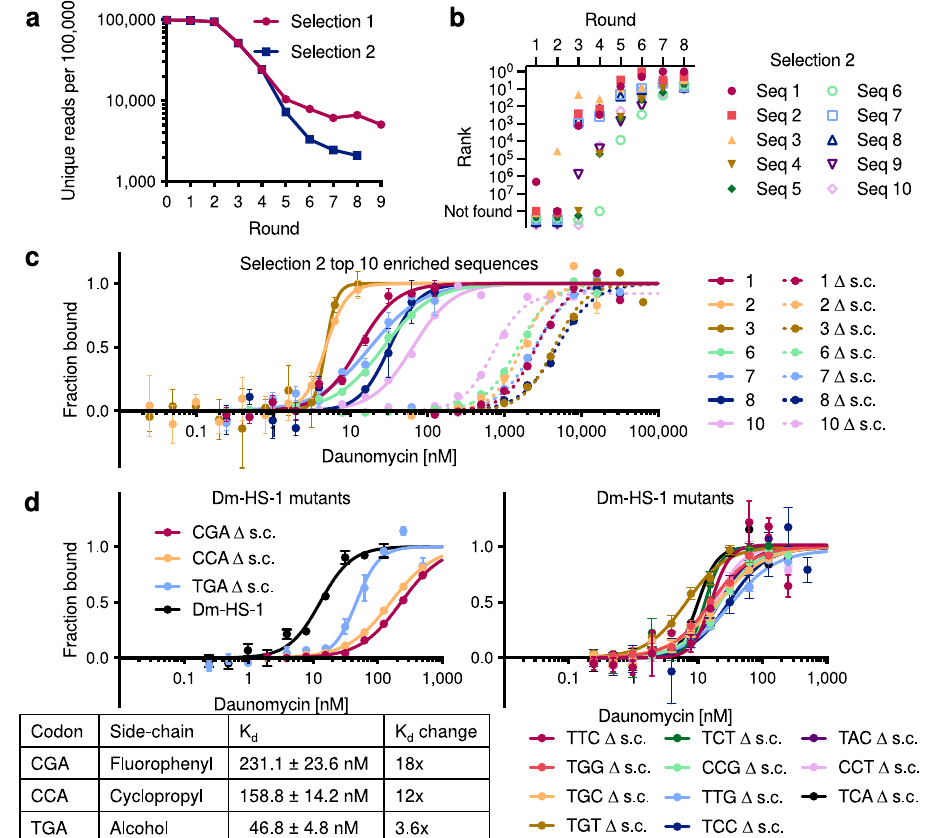
Fig.3|Increasedselectionstringencyyieldsmorepotentdaunomycin-binding HFNAPs. a Sequence convergence for selection 1 and selection 2. b The evolu- tionary trajectory of the top ten most enriched sequences in selection 2. c MST characterization of the binding af fi nity for the top ten most enriched sequences fromselection2.Dm-HS-4,5,and9areomittedforclarity,asDm-HS-1,4,5andDm- HS-3, 9 are each related by 1 nucleotide. 1 Δ s.c. denotes the sequence (Dm-HS-1) without side-chains. Sequences were found to bind with K d =5 – 65nM. Values and errorbarsre fl ectthemeanandSEMfor n =3independentreplicates.Errorbarsfor